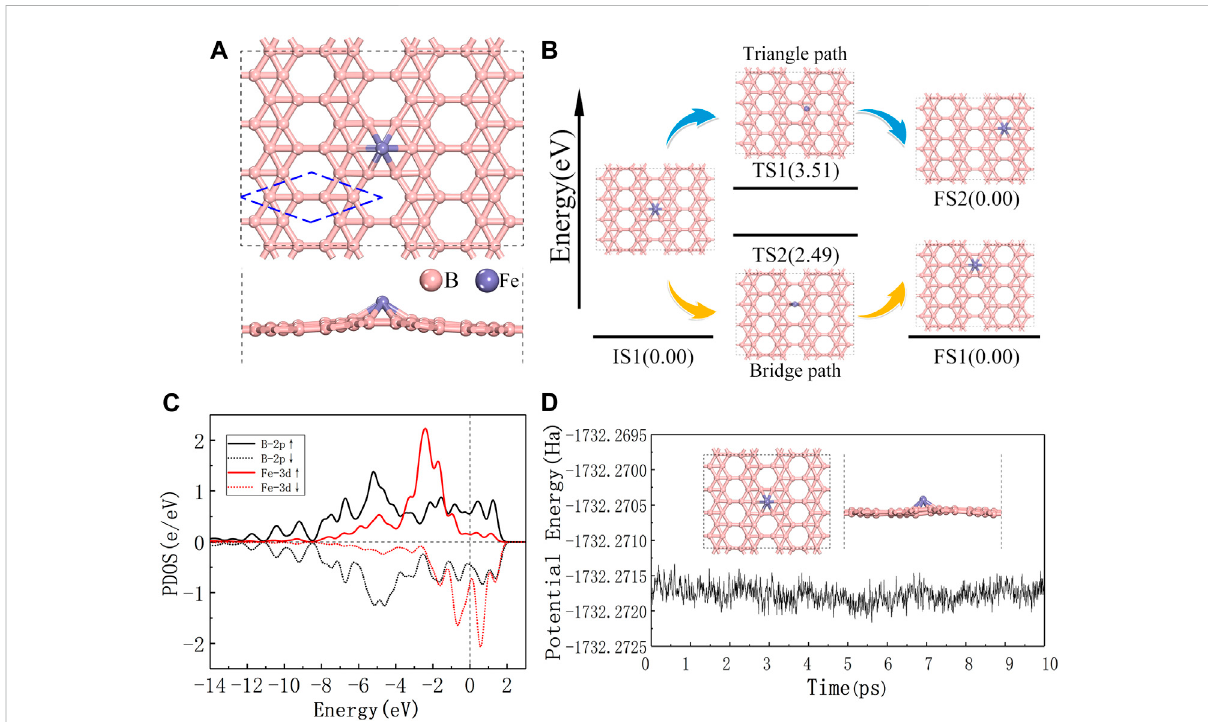
FIGURE 1 (A) Topandsideviewsofthemoststablecon fi gurationsofsingleFeatomadsorbedon χ 3 -borophene,thebluedashedlineistheprimitivecellof fi le for Fe atom diffusion on χ fi gurations involved. (C) The spin polarized partial χ 3 -borophene. (B) The energy pro 3 -borophene surface with the con density of states for Fe atom and the 6 B atoms around it, the vertical dashed line at 0 eV is the Fermi level. (D) Ab-initio molecular dynamics calculation of Fe@ χ 3 -borophene at 300 K, the trajectory length is 10 ps, the inserted fi gure shows the structure of the system after 10